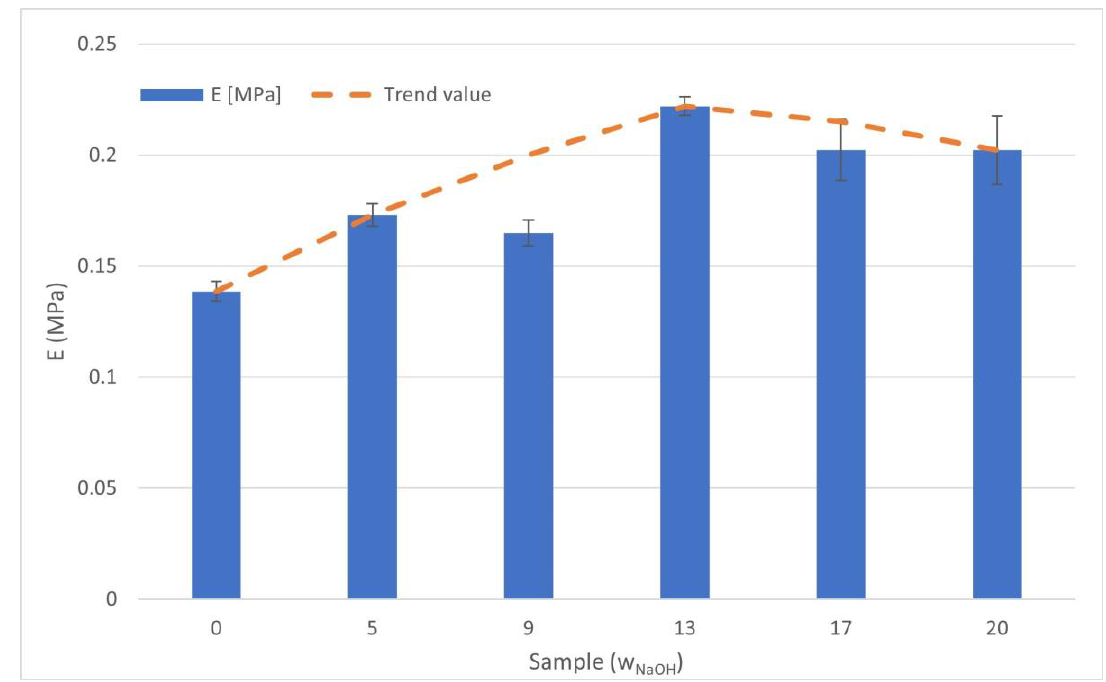
Figure 12. Compressive elastic modulus of prepared samples. Bars show the mean value with SD, N = 4, and the dashed line represents the trending value. A lower value of sample 9 μL/mL was possibly caused by the formation of microbubbles in the sample that resulted in a more compressible structure.